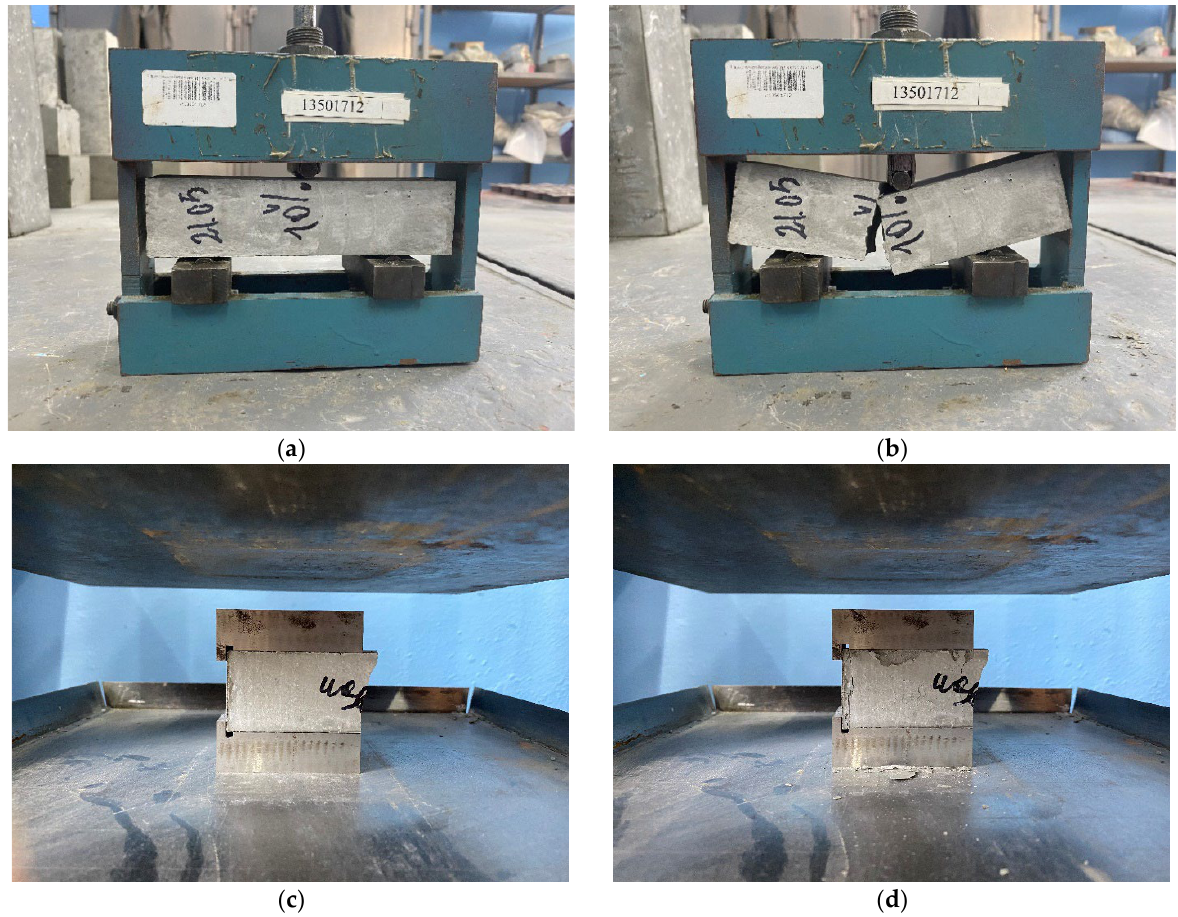
Figure 5. Samples of hardened cement paste modified with RSA and activated by electromagnetic treatment in a bending test: ( a ) to failure; ( b ) after failure and in compression test: ( c ) before failure; ( d ) after destruction.